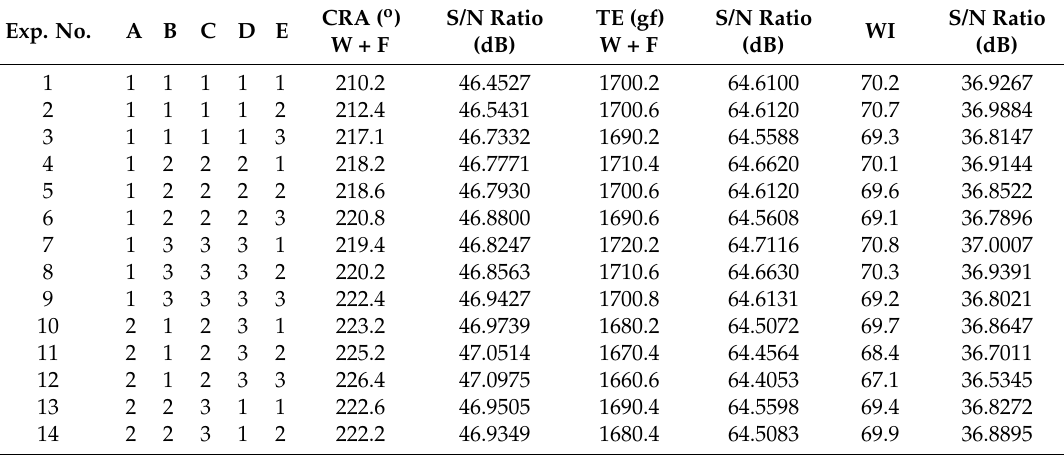
Table 2. Experimental layout using an (L 27 ) OA and multi-performance